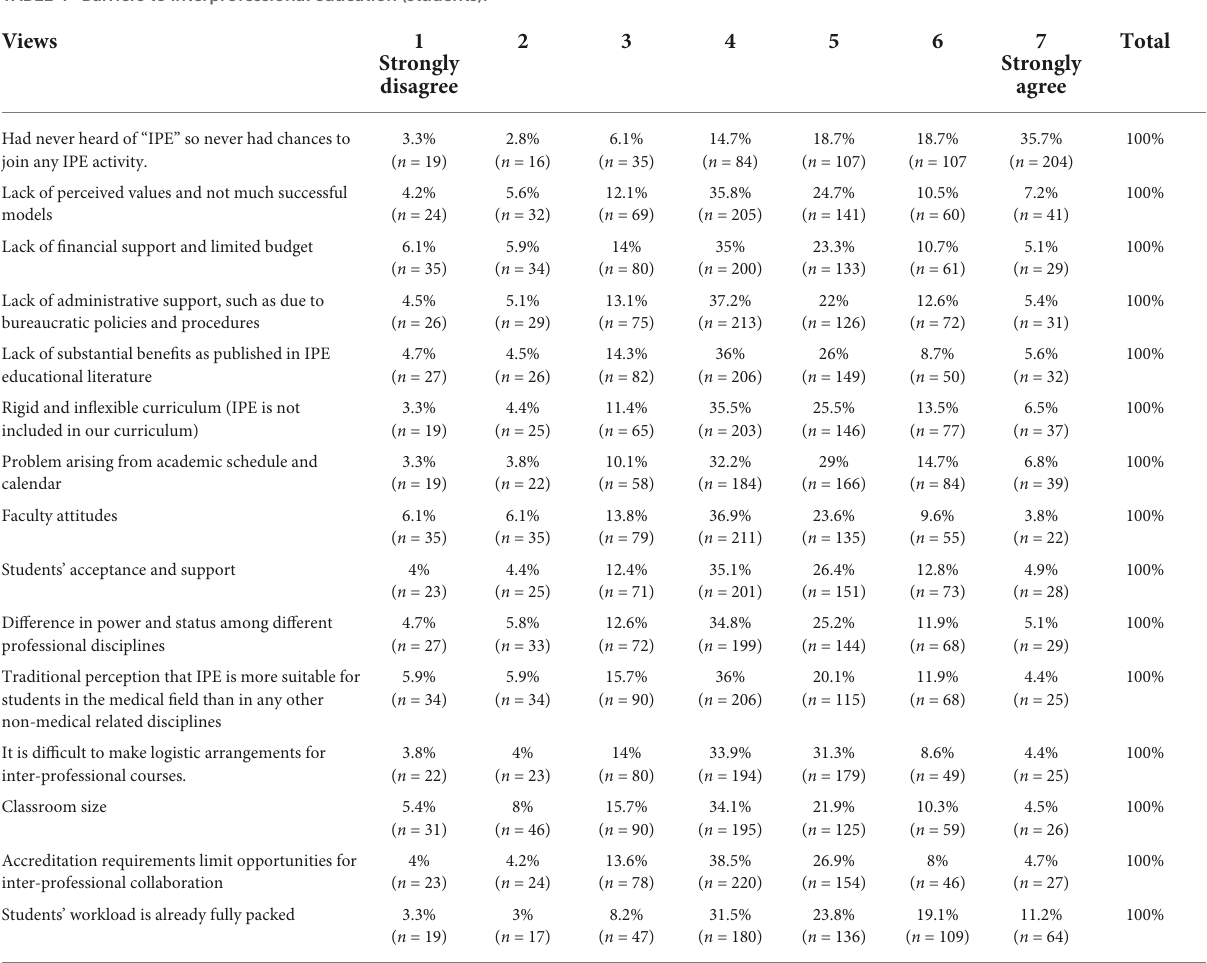
TABLE 4 Barriers to interprofessional education